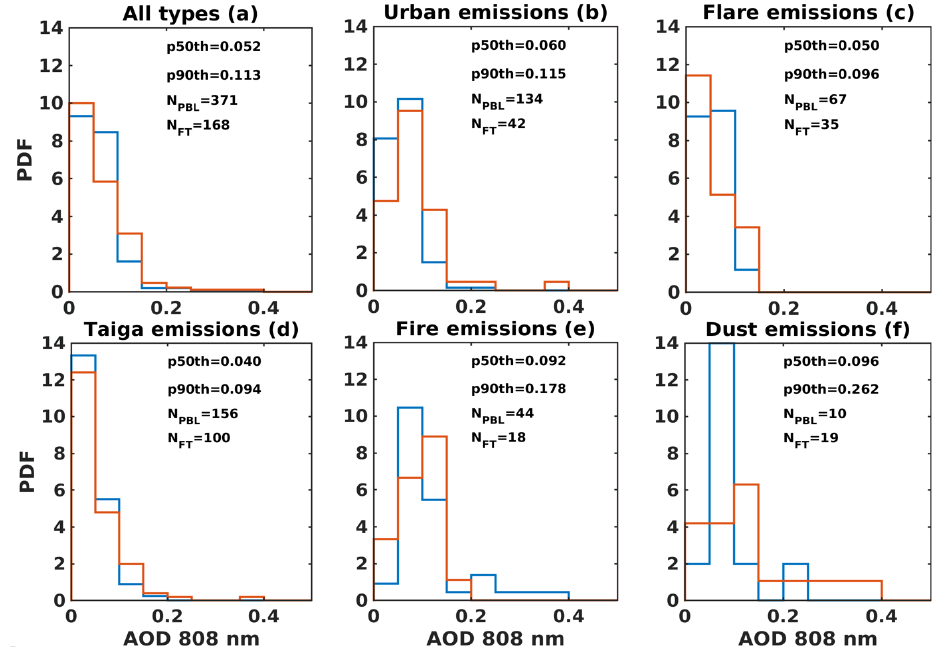
Figure 17. PDF of the 808nm AOD lidar according to the different aerosol types: all (a) , urban (b) , flaring (c) , natural emissions from Siberian forest and grasslands (d) , biomass burning (e) and dust (f) . Blue PDF is for aerosol-weighted altitude z aer < = 1 . 75km and red for z aer > 1 . 75km. N PBL and N FT are respectively the number of PBL only and PBL plus FT observations, while p50th and p90th are respectively the median and 90th percentile of the AOD distribution for both altitude